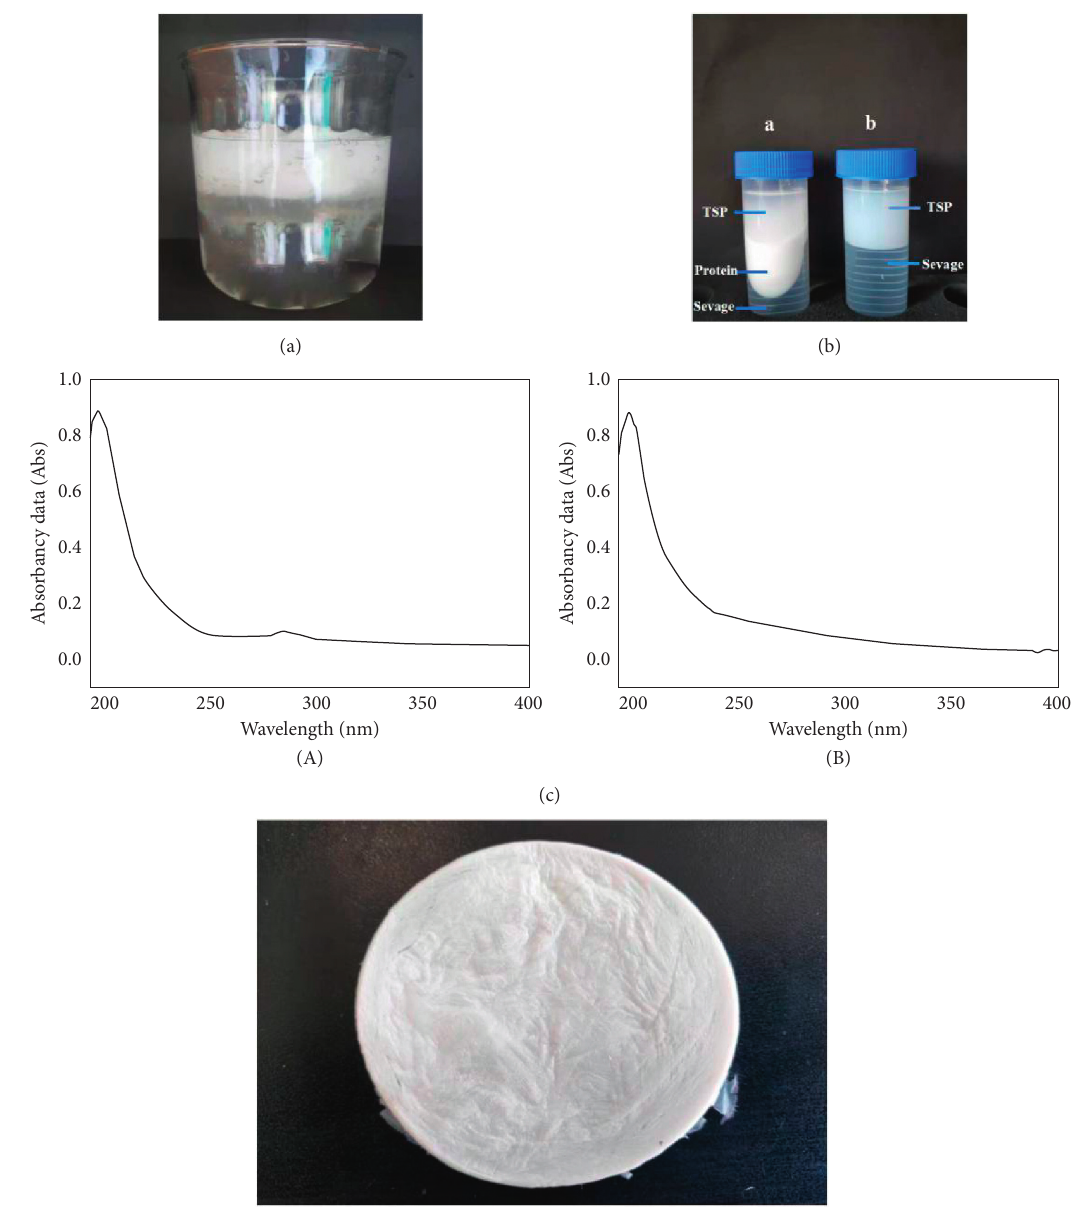
Figure 1: Preparation, purification, and acquisition of TSP. (a) The solution was precipitated with 95% (v/v) ethanol at 4 ° C overnight. (b) Deproteinization: (A) remove protein of TSP by Sevage solution for the first time and (B) remove protein of TSP by Sevage solution for the fifth time. (c) Scan of TSP during the range of 190–400nm: (A) crude polysaccharides and (B) TSP after removing impurities. (d) TSP (impurities removal) lyophilized